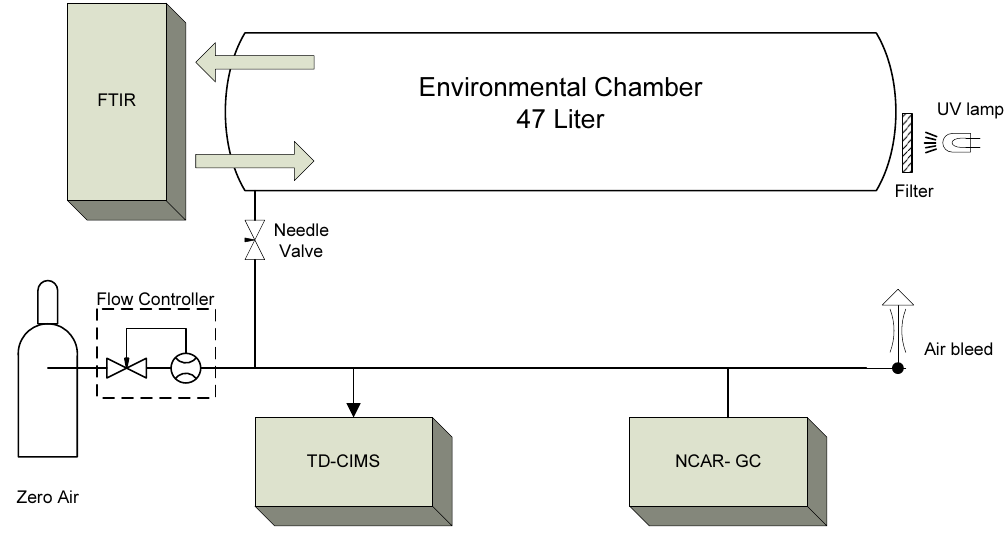
Fig. 3. Schematic of the TD-CIMS and GC measurement of PAN produced in the environmental